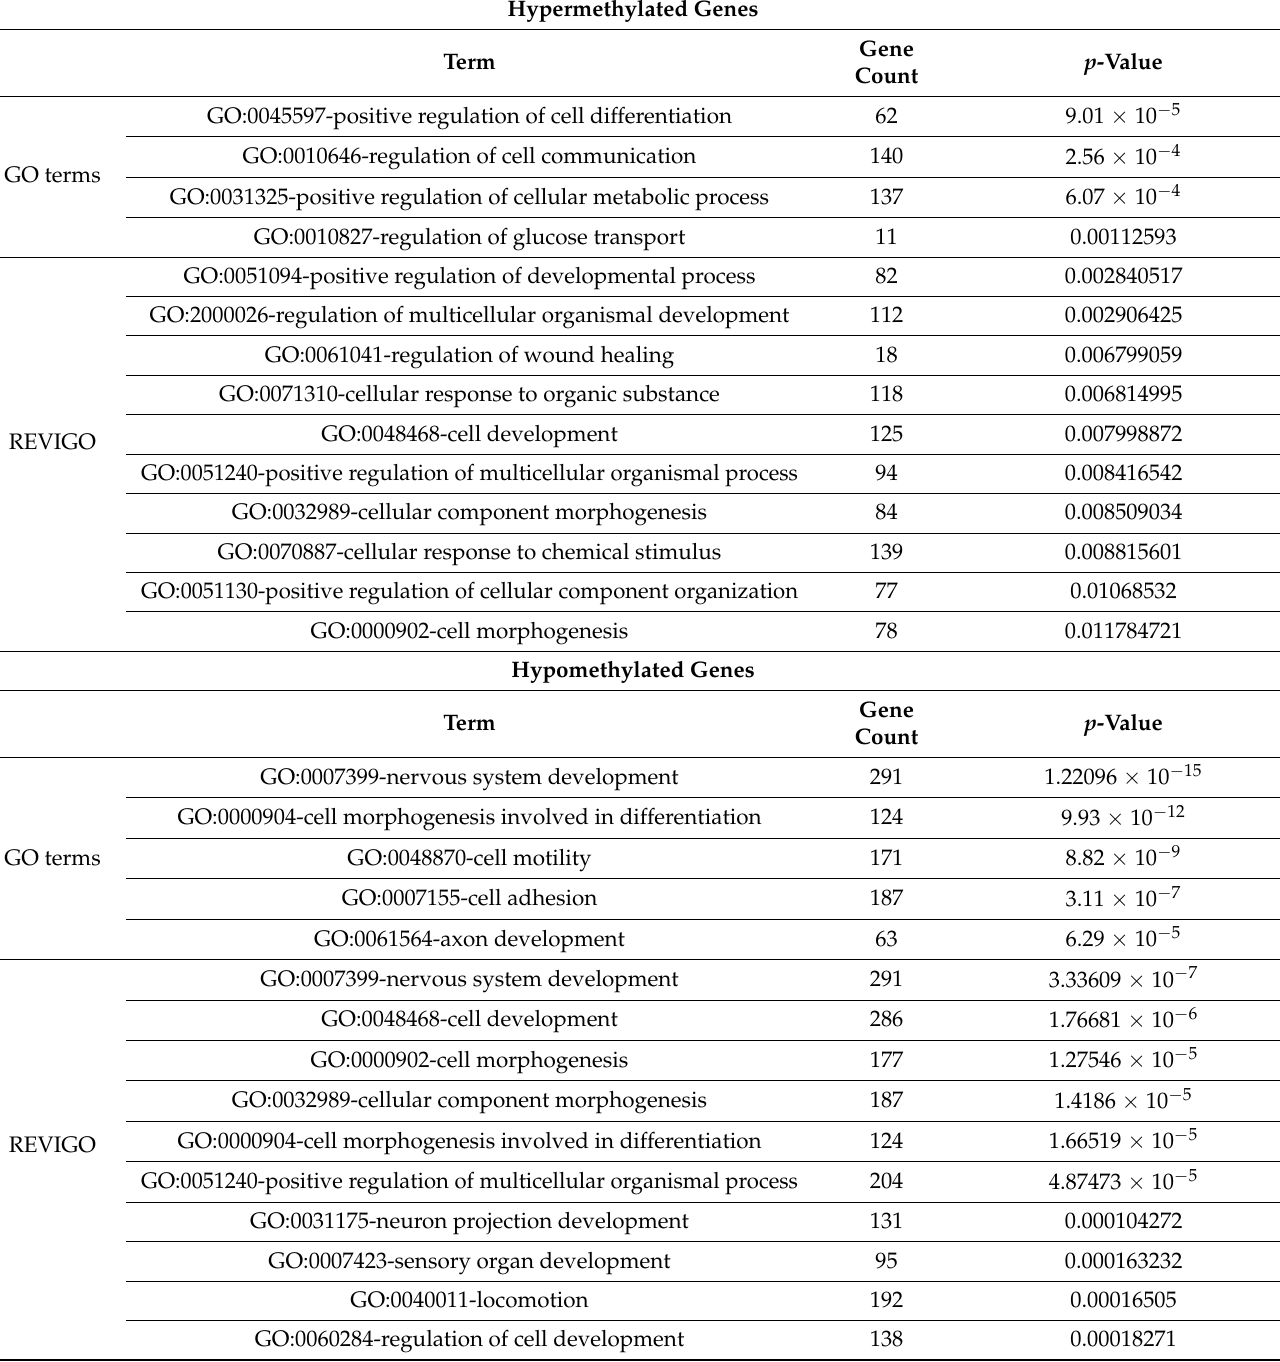
Table 2. Gene ontology and REVIGO terms of differentially methylated genes in HG-mESC compared to